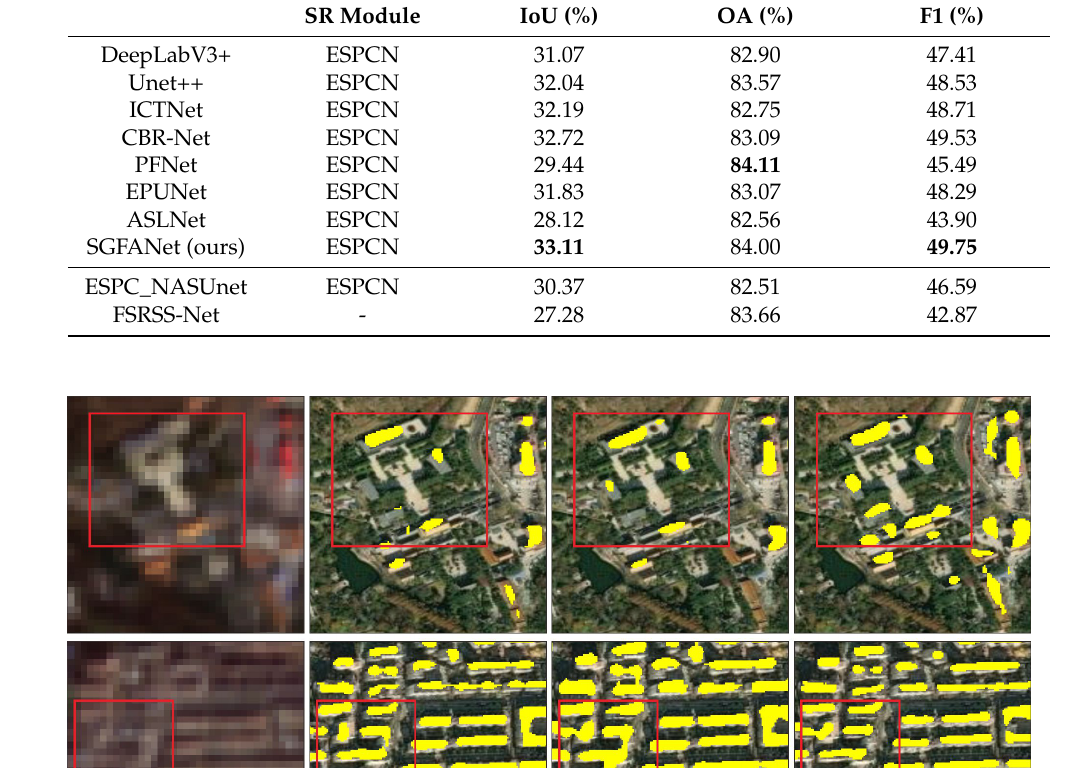
Table 3. Comparison with the related results based on the SR-then-SS framework. The bold values in each column means the best entries.